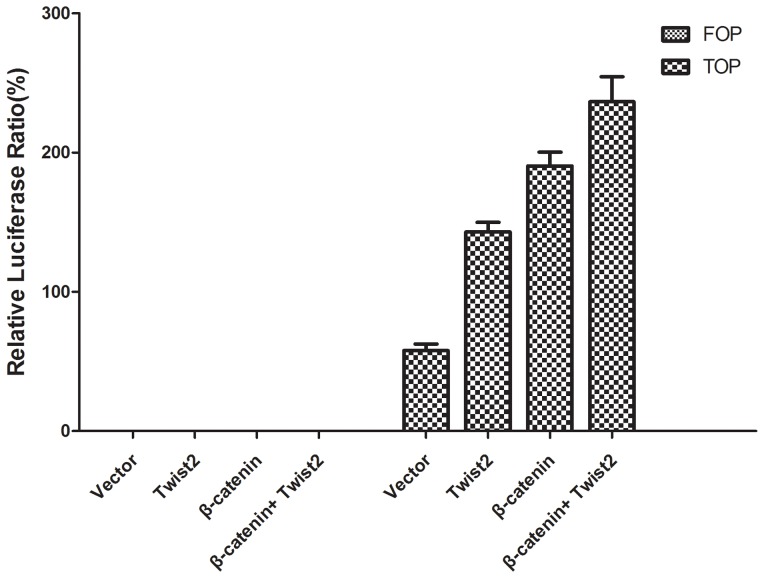
TCF/LEF-dependent transcriptional activity TOP/FOP flash.In order to measure TCF4/LEF1-dependent transcriptional activity of 293FT cell lines, cells were transfected with TOP/FOP flash reporter plasmids. After genes transfection for 48 h, transcriptional activity was measured by using Dual Luciferase Reporter Assay System. Cells in FOP flash groups showed negligible levels of transcriptional activity. In contrast, cells in TOPflash groups co-transfected with Twist2 showed significant increase in signal. The results are the average ± s.d. of three experiments (N = 3; P<0.001).